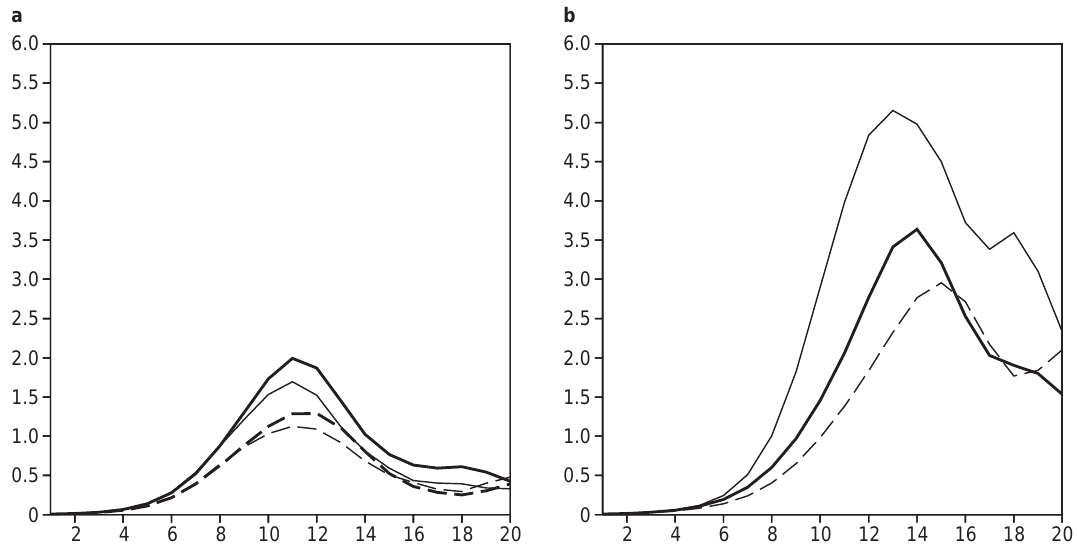
Fig. 11a,b. Time development of eddy kinetic energy, K e for life cycle experiments based on ‘control’ ( solid lines ) and ‘2 (cid:2) CO 2 ’ ( dashed lines ) basic states. a DRY lifecycles ( heavy curves ) and life cycles with just large-scale rain included ( lighter curves ). b life cycles with large-